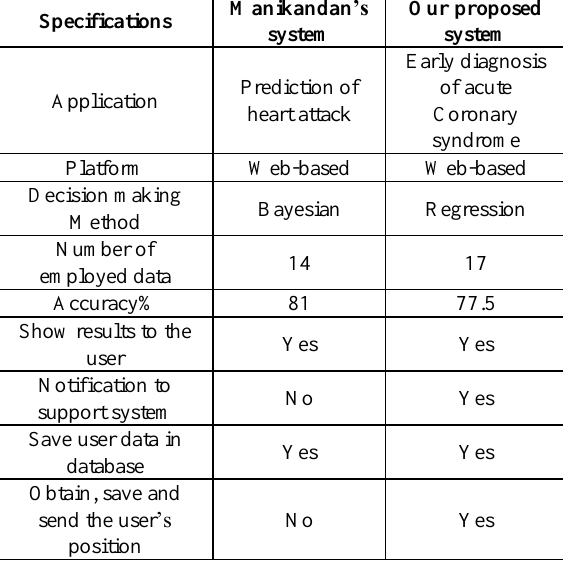
Table 3. Comparison of the proposed system with that of Manikandan